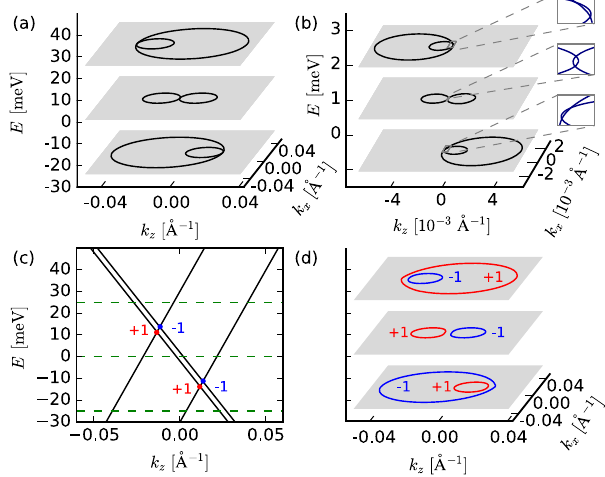
FIG. 2. (a) [(b)] Fermi surfaces for type-A [type-B] triple point topological metals at three different energy cuts: below, between, and above the two triple points. The three small insets in (b) show that for the type-B scenario there are several distinct touching points between the Fermi pockets. (c) Band structure around the triple points for a small Zeeman field parallel to the C 3 axis. (d) Fermi surface of type-A triple point topological metal with a small Zeeman field. In (c) and (d) the Chern numbers of WPs and Fermi surfaces are marked in red ( þ 1 ) and blue ( − 1 ).